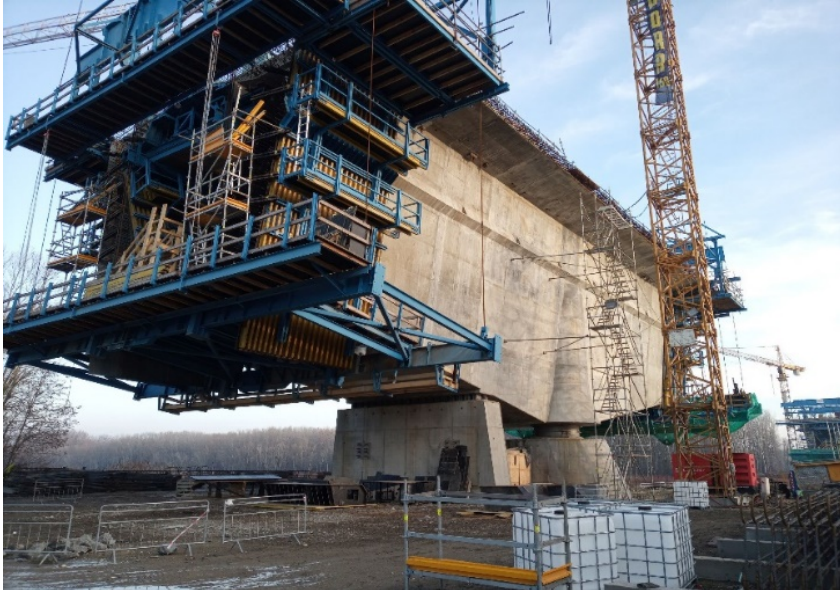
Figure 12. Balanced cantilever under construction at pier